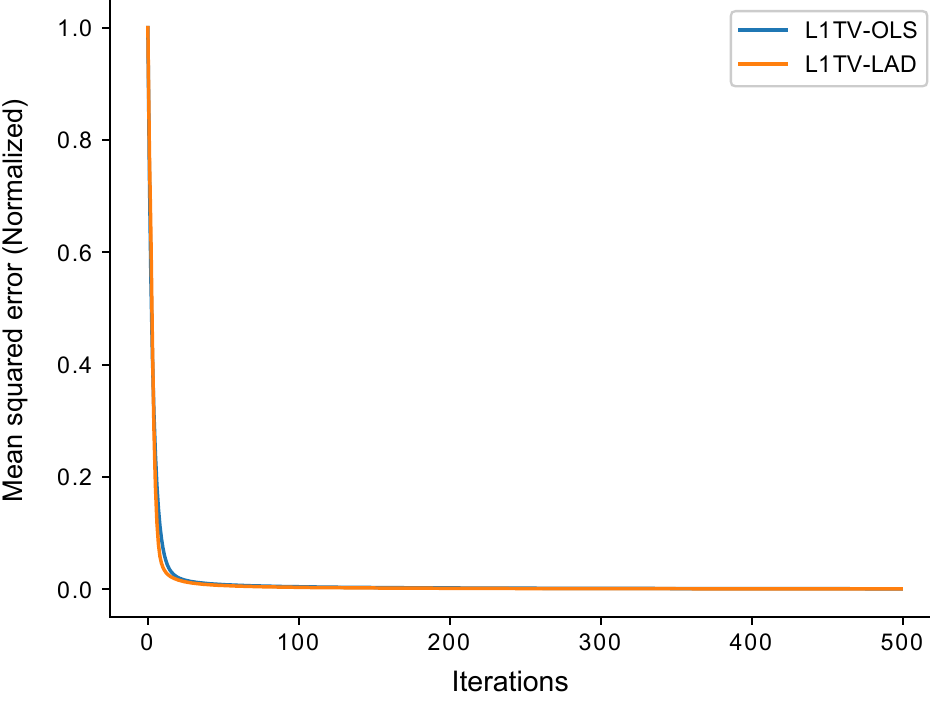
Figure 8. The mean squared error (MSE) of two iterative NUFFT algorithms—L1TV-OLS and L1TV-LAD—which converge within 500